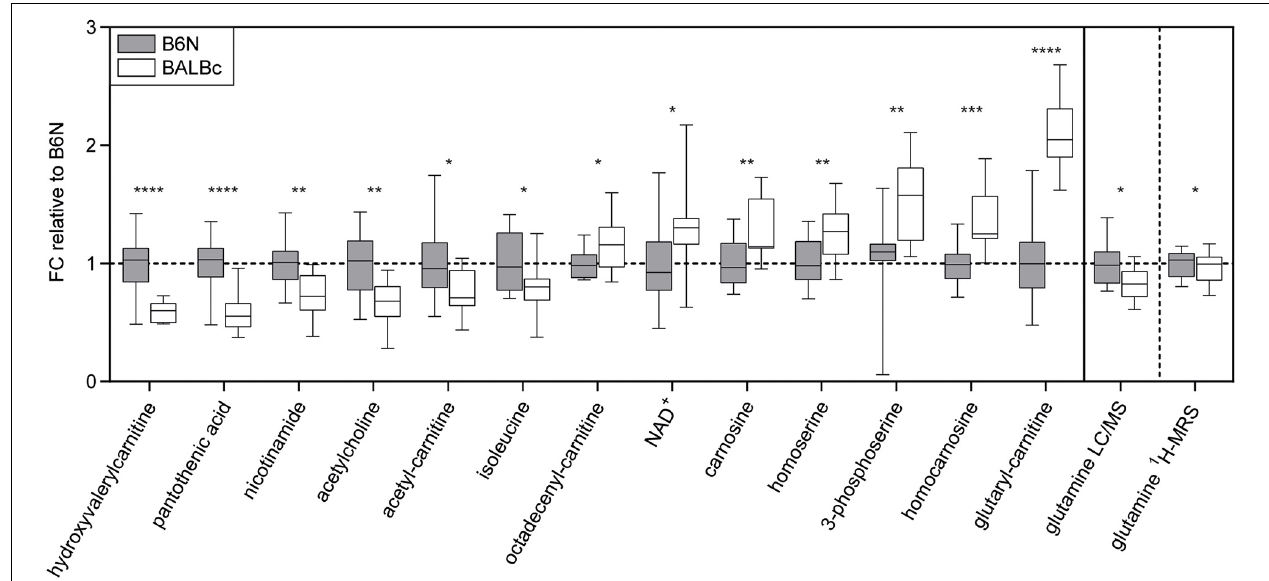
FIGURE 5 | Metabolomics. Significant strain differences of metabolite levels in the dorsal hippocampus of B6N ( n = 12) and BALBc mice ( n = 15) from Experiment 2 revealed by mass spectrometry, aligned according to the effect sizes. Results are normalized to metabolite abundances in B6N mice, y -axis shows the fold change (FC). Glutamine 1 H-MRS levels obtained before training in Experiment 2 were re-analyzed and are presented on the right panel of the figure. * p < 0.05, ** p < 0.01, *** p < 0.001, **** p < 0.0001 (student’s t